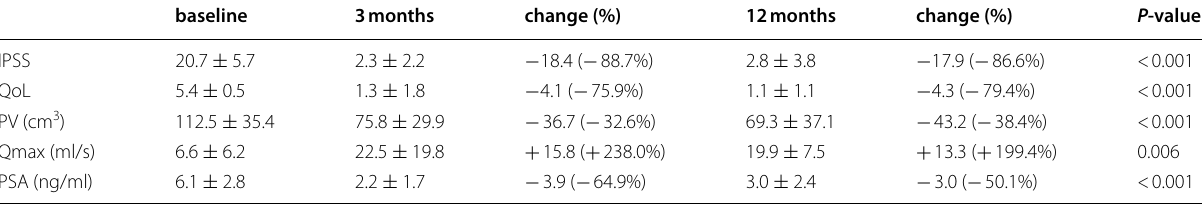
Parametric variables described as means standard deviations ± IPSS International Prostate Symptoms Score, QoL Quality of life, Qmax Peak urinary flow rate, PV Prostatic volume